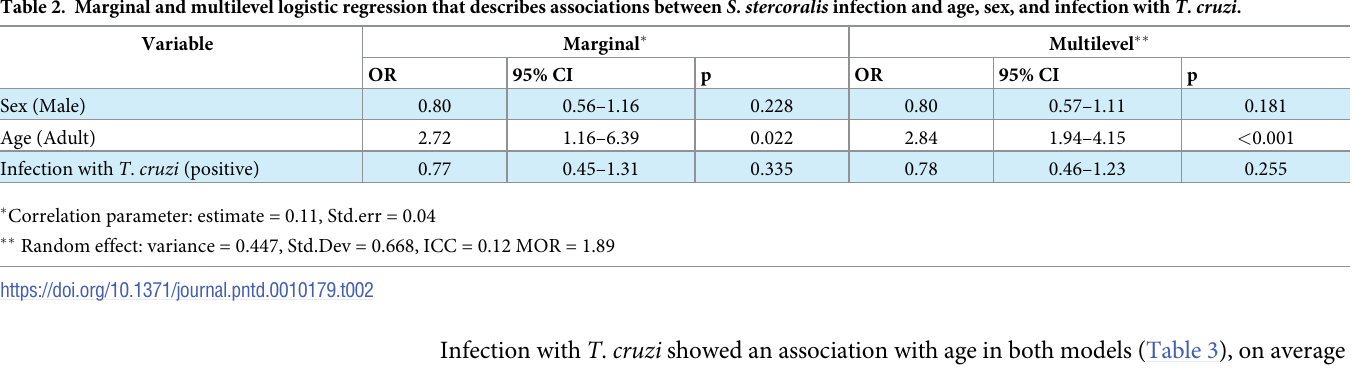
Infection with T . cruzi showed an association with age in both models (Table 3), on average adults have 5.12 higher odds than children, and at the individual level adults have 5.48 higher odds than children. In addition, the multilevel model estimated that 2% of variance (ICC = 0.02) of infection with T . cruzi can be explained by the differences between villages; and If two individuals with the same characteristics in different villages are compared, there would be a median increase in the odds of infection of 1.31 (MOR = 1.31).